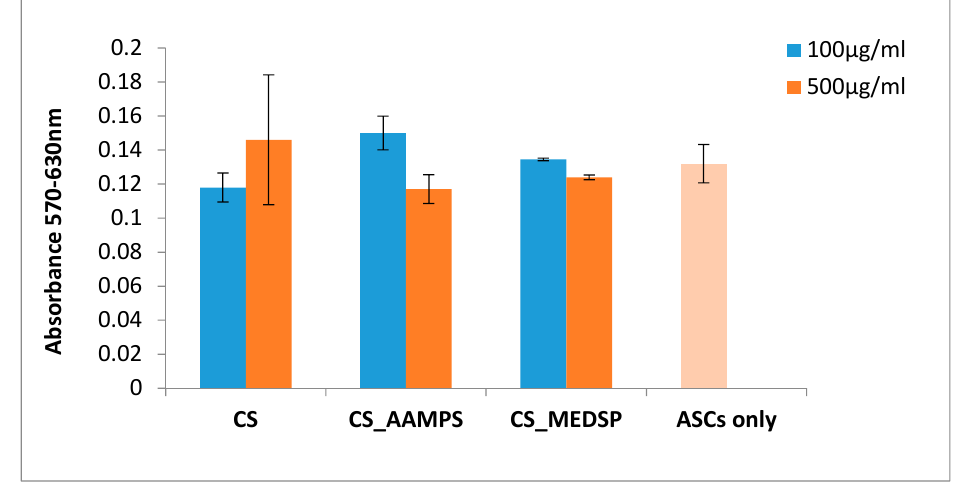
Figure 3. Cells viability was determined by MTT assay cells’ treatment with our samples for 24 h. The absorbance values are directly proportional to metabolic activity of the cells.